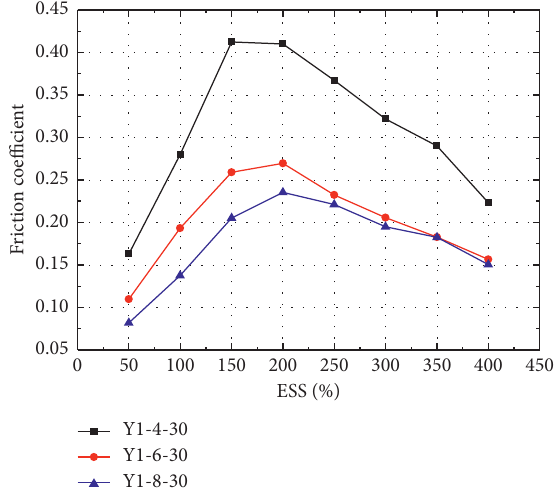
Figure 7: Observed friction ( μ ) versus ESS. Table 2: The distribution of bearing